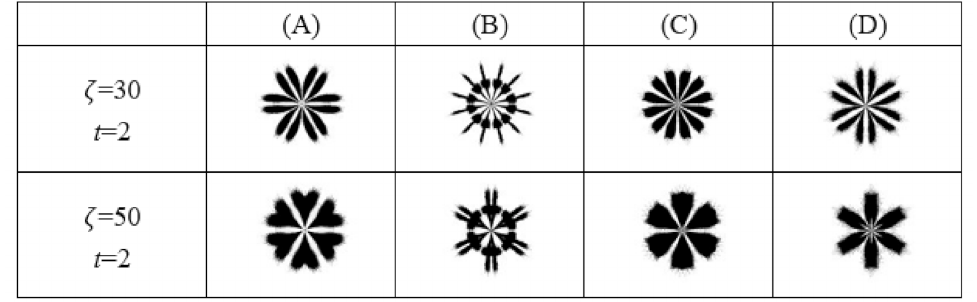
Figure 15. SDP figures of four test motors with time delay coefficient is 2 with various weighting coefficient for four different